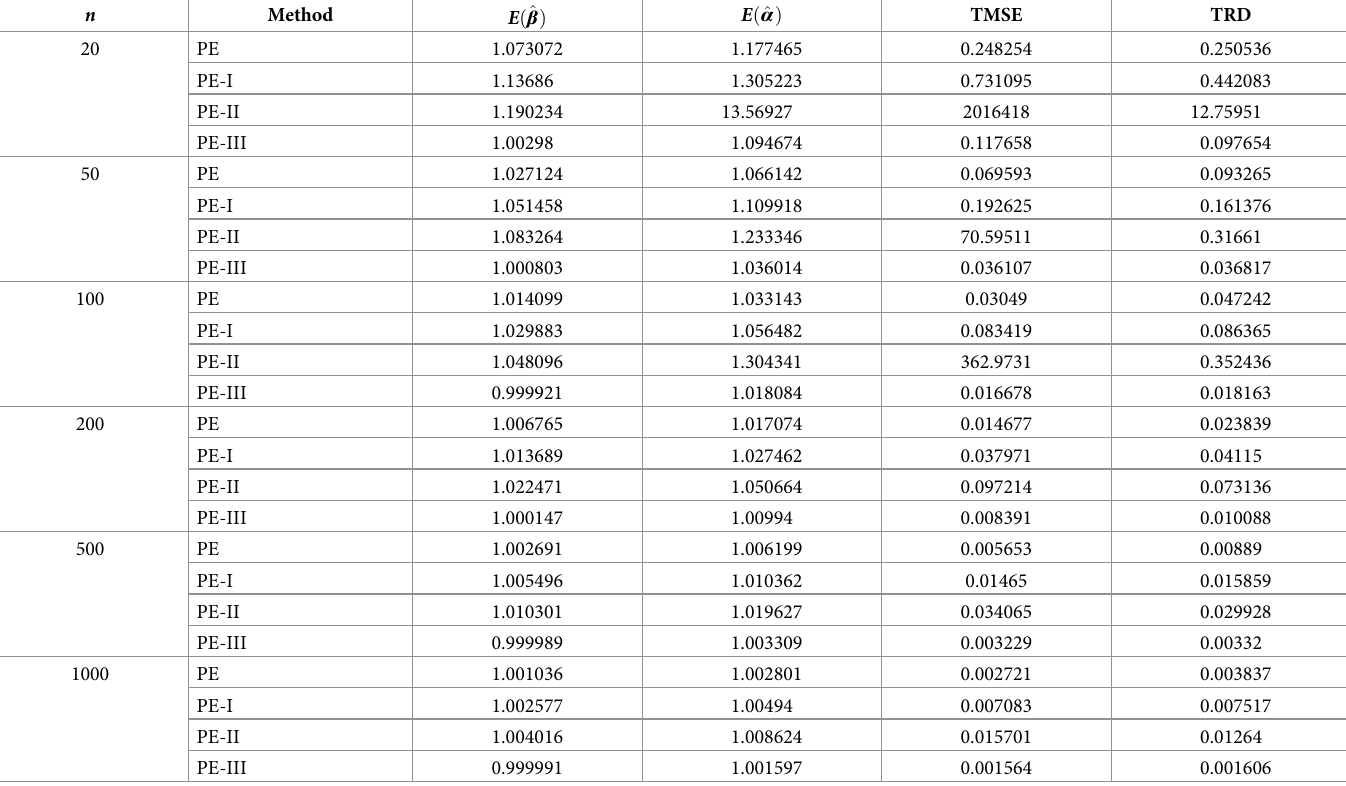
Table 2. Comparison of PE and modified PE for β = 1, α =